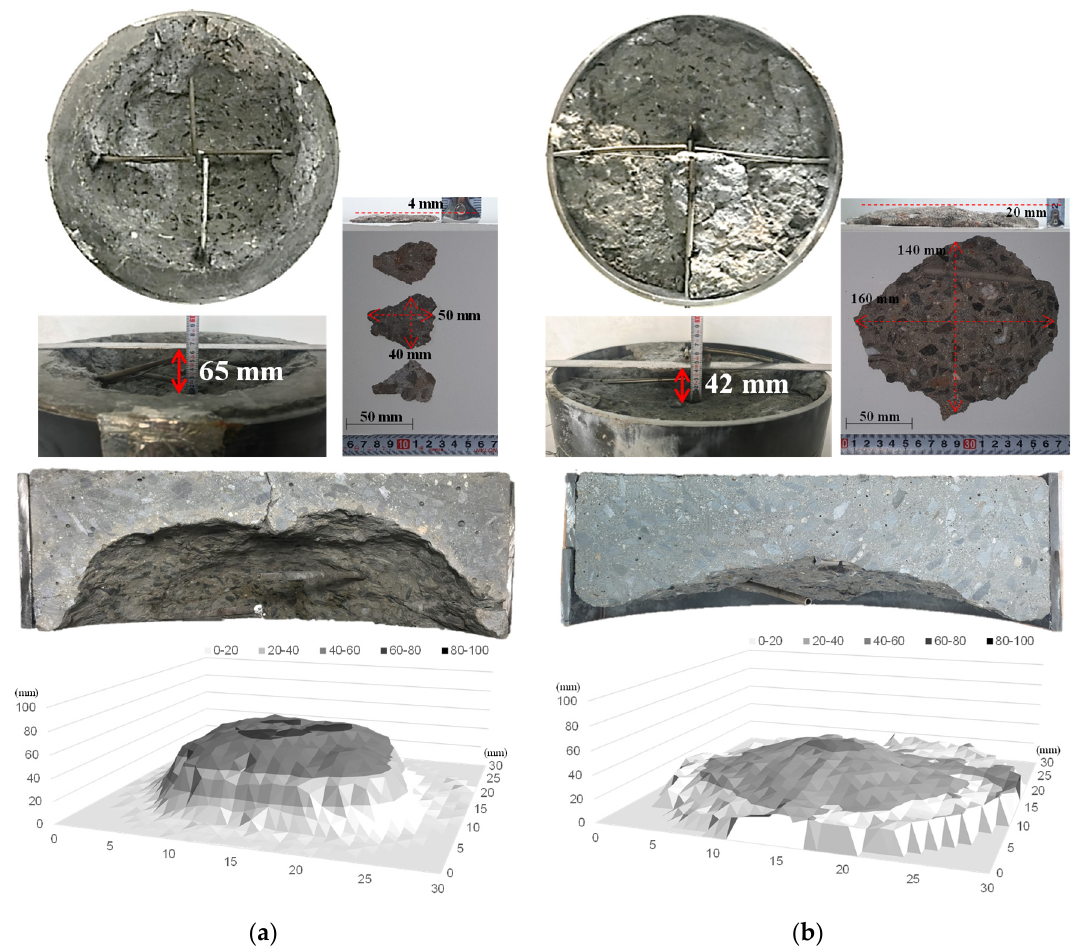
Figure 5. Spalling behavior of 100-MPa concrete according to heating rate. ( a ) Fast heating (ISO-824). ( b ) Slow heating (1 °C/min).